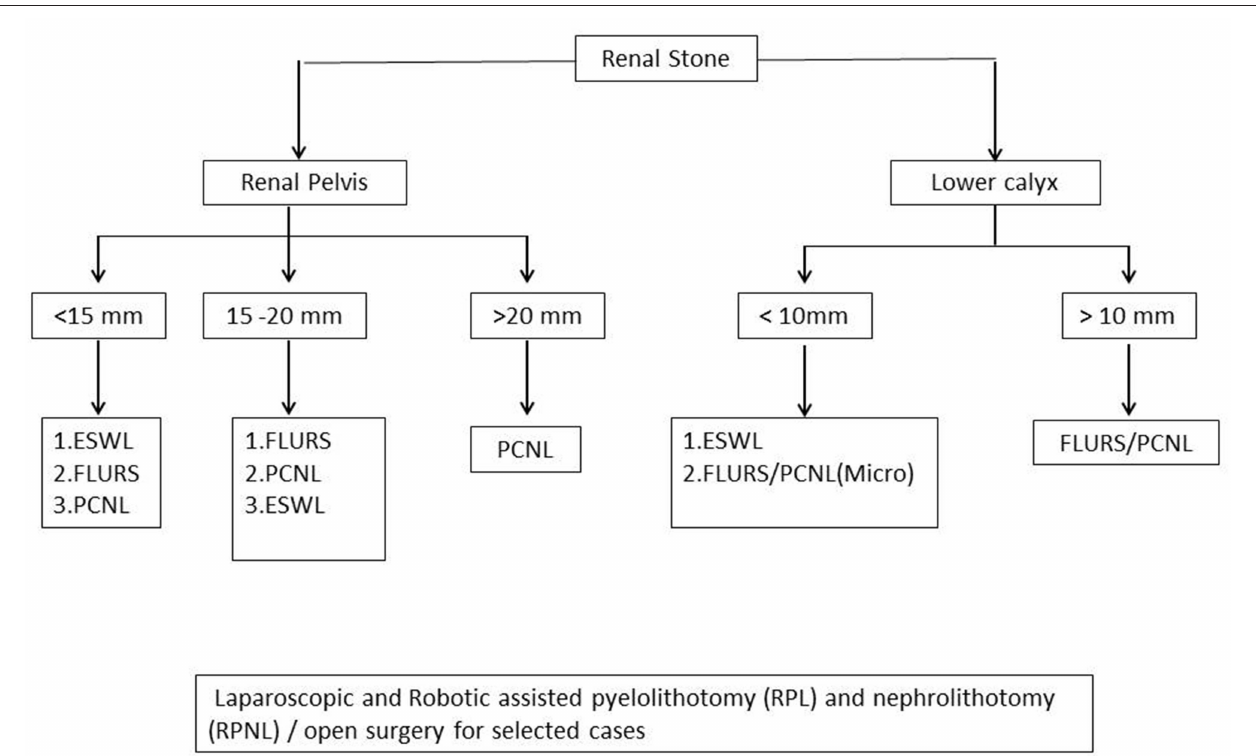
FIGURE 1 | Minimally invasive surgery for renal stone management